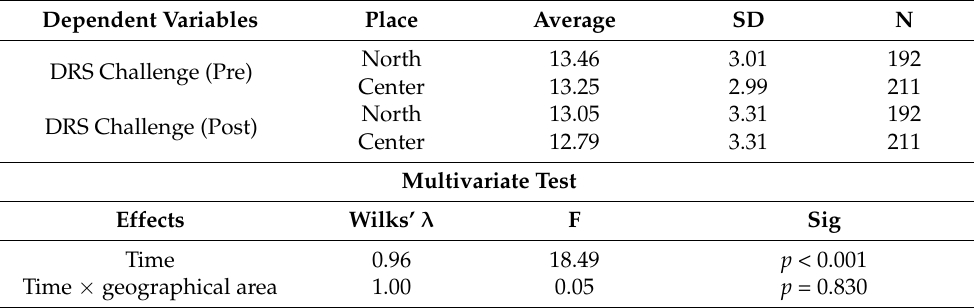
Table 17. Repeated measures ANOVA model of time (i.e., pre- and post-pandemic first-wave effect) and geographical area effects on challenge